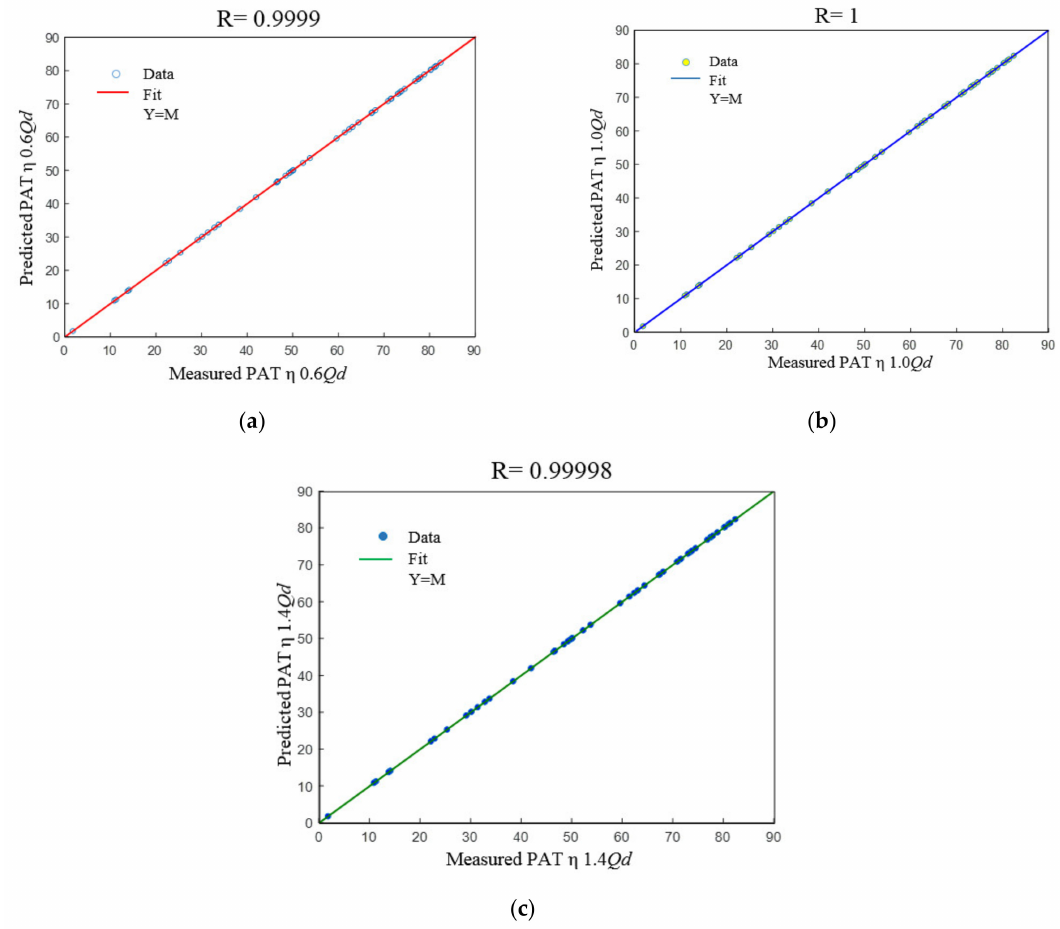
Figure 16. R-Square analysis of PAT e ffi ciency: ( a ) 0.6 Q d , ( b ) 1.0 Q d, and ( c ) 1.4 Q